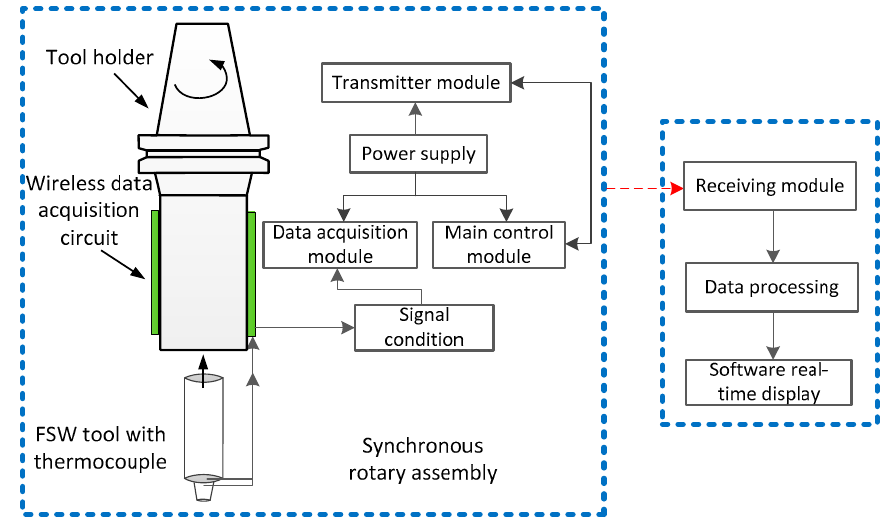
Figure 3. Schematic diagram of the main components of the FSW wireless temperature measurement system.